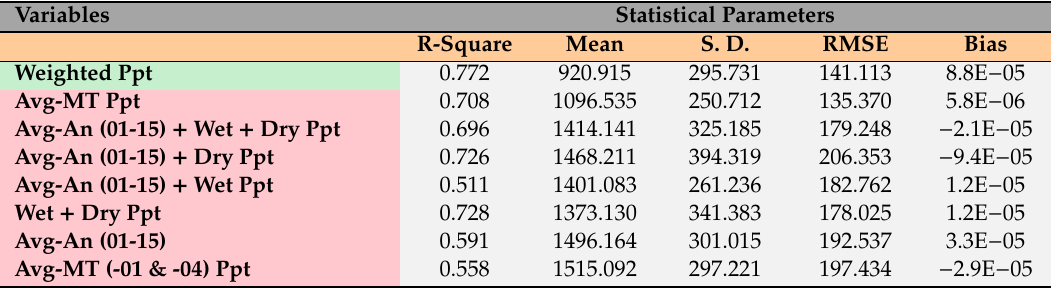
Table 5. Comparison between the weighted precipitation and classified extracted precipitation